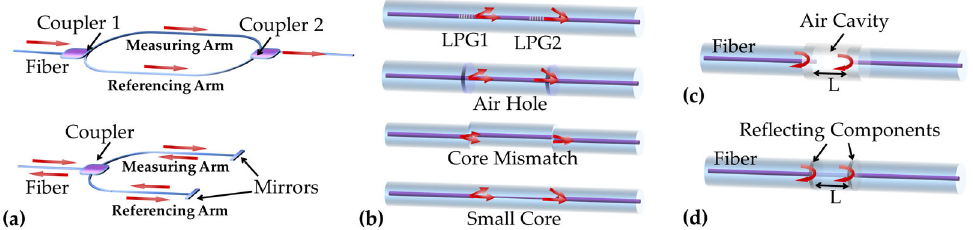
Figure 2. ( a ) Configurations of typical optical fiber MZI; ( b ) configurations of various types of in-line optical fiber MZIs. ( b ) Configuration of extrinsic ( c ) and intrinsic ( d ) FPI based on optical fiber.